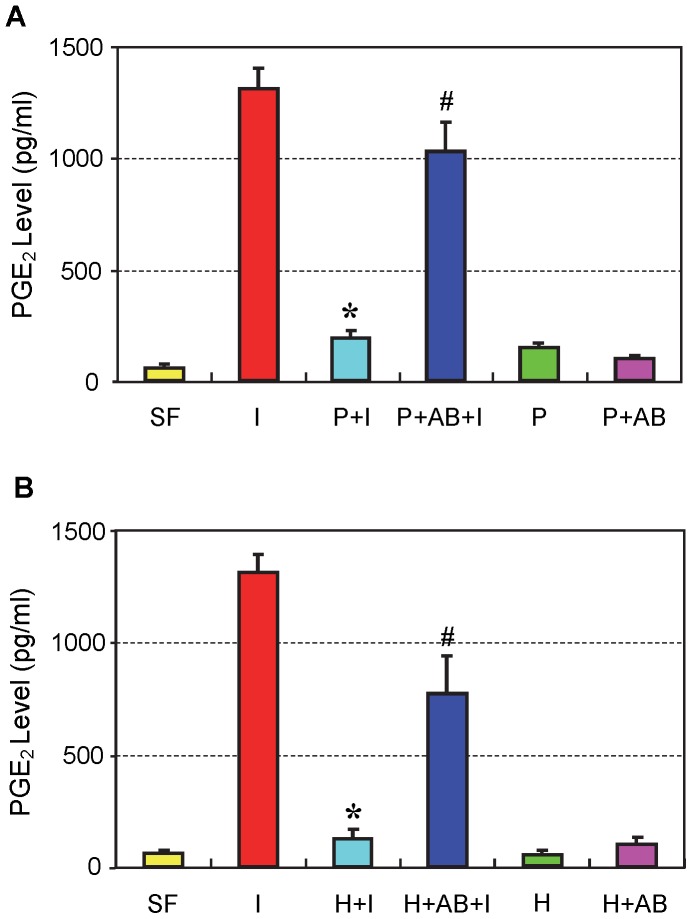
The effects of PRP (A) and HGF (B) treatments on PGE2 production in tendon cell culture.IL-1β treatment (I) induced high levels of PGE2 production in cells compared to levels induced by control conditions (SF); however, these increases in PGE2 were markedly reduced by PRP or HGF treatment. Note that *P<0.05 is with respect to IL-1β treatment condition (I); and #P<0.05 is with respect to the PRP+IL-1β (P+I) group in A and the HGF+IL-1β (H+I) group in B. The data are expressed as mean ± SD, n  = 4. Label abbreviations and concentrations of all agents (IL-1β, PRP, HGF, and HGF antibody) are identical to legends in
Figure 2
. For SD values that are barely visible, the variation in gene expression values was less than 5 (control group, SF is 1).